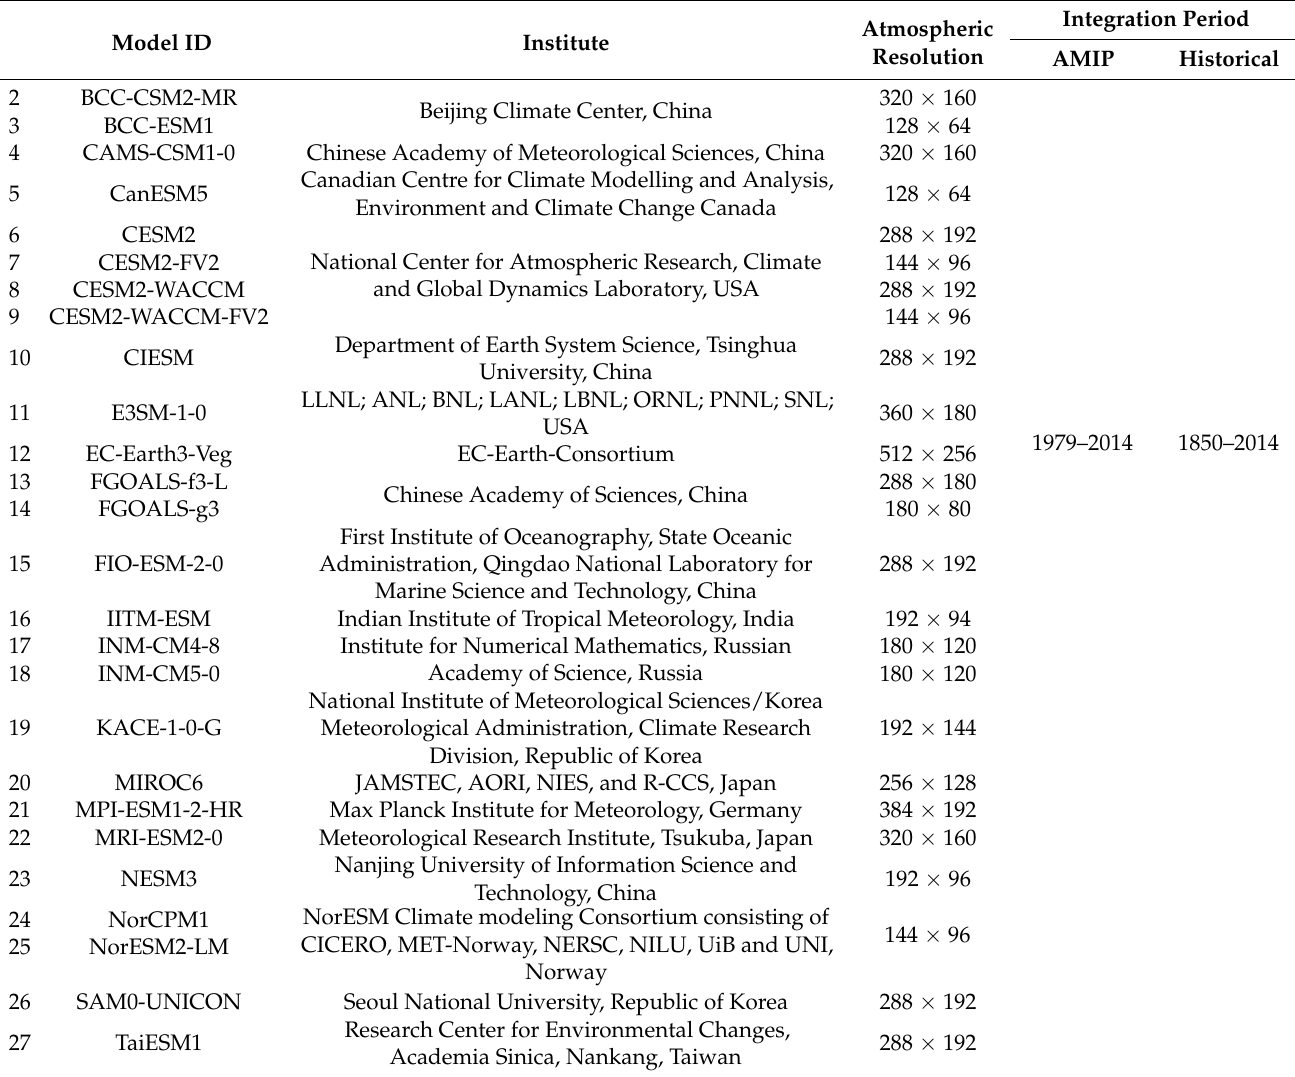
Table 1. Information on the CMIP6 models used in this